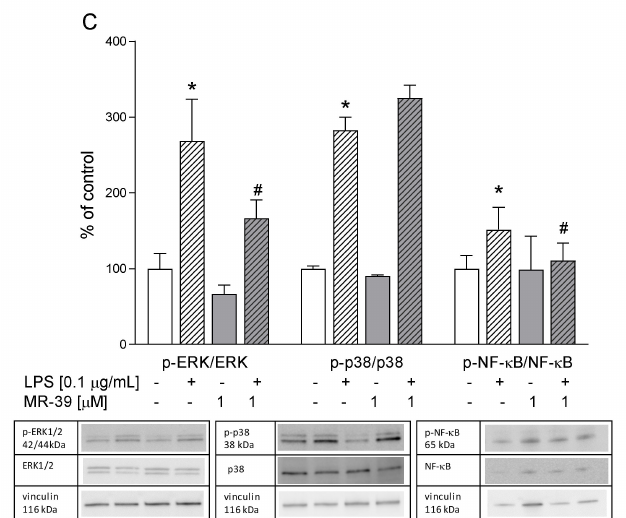
Figure 11. The impact of LXA4, AT-LXA4, and MR-39 on extracellular kinase 1/2 (ERK1/2), p -38 mitogen-activated protein kinases ( p -38 MAPK), and nuclear factor kappa-light-chain-enhancer of activated B cells (NF- κ B) pathways measured using Western blot analyses of microglial cells. The cells were treated with LXA4 (0.1 µ M; A ), AT-LXA4 (0.1 µ M; B ), or MR-39 (1 µ M; C ) for 1 h and then stimulated with LPS (0.1 µ g/mL). Control cultures were treated with the appropriate vehicle. The data are presented as the mean ± SEM percentage of the control (vehicle-treated cells) of independent experiments, n = 2–5 in respective experiments. Representative immunoblots are presented under each graph. * p < 0.05 vs. the control group, # p < 0.05 vs. the LPS group.—LXA4: lipoxin